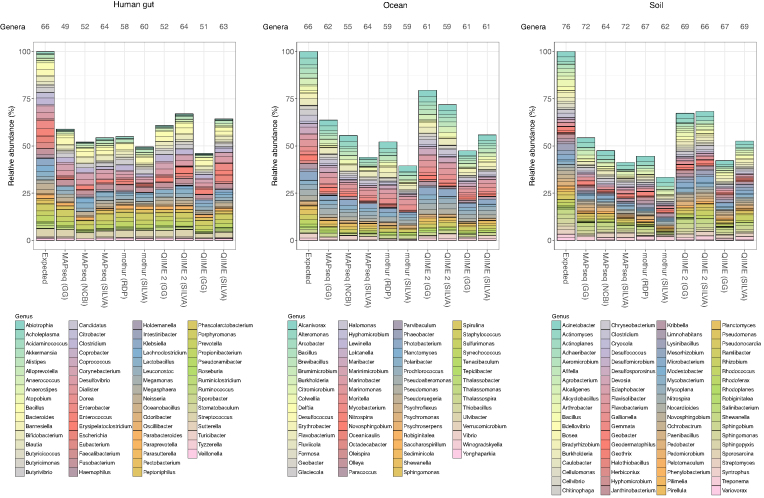
Level of recall at the genus level, represented as taxa relative abundances, obtained with each analysis pipeline for the three different biomes (human gut, ocean, and soil). The number of genera correctly identified by each pipeline is indicated above the graph.